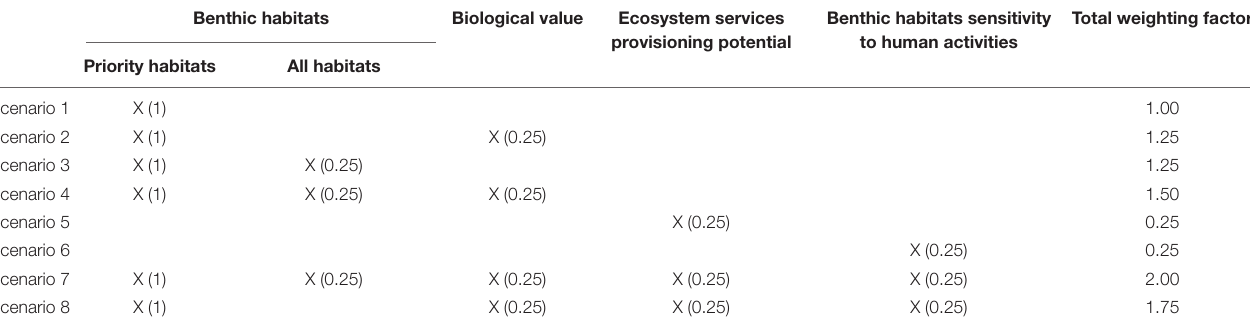
TABLE 1 | Conservation features considered in each of the defined scenarios, including the weighting